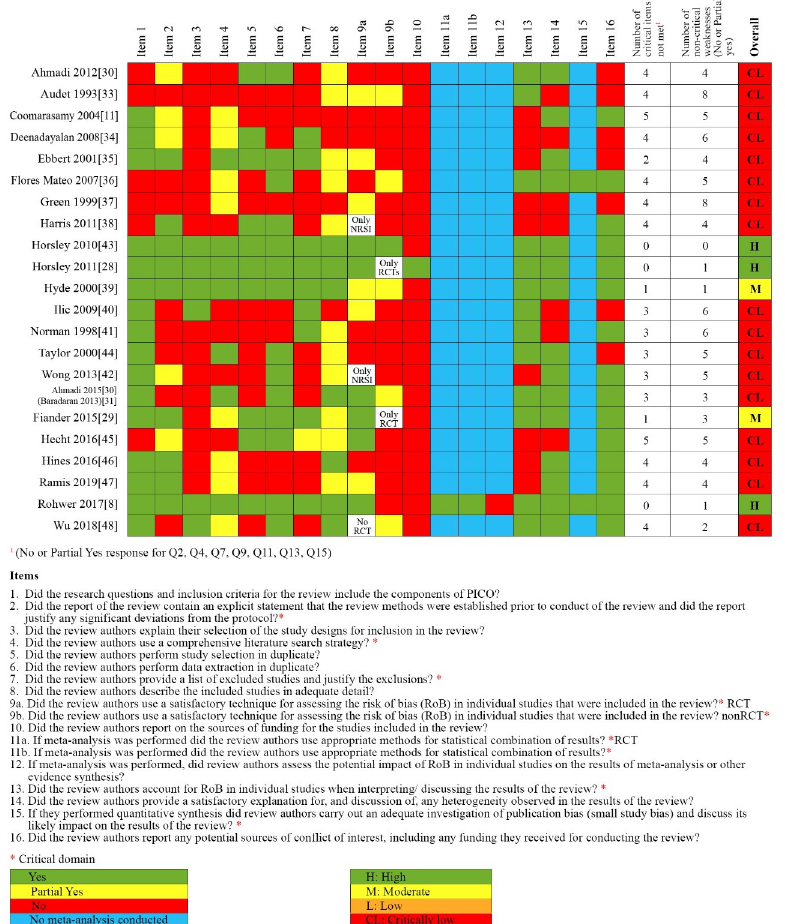
Fig 2. Methodological quality of all reviews included in the update of the overview using AMSTAR 2